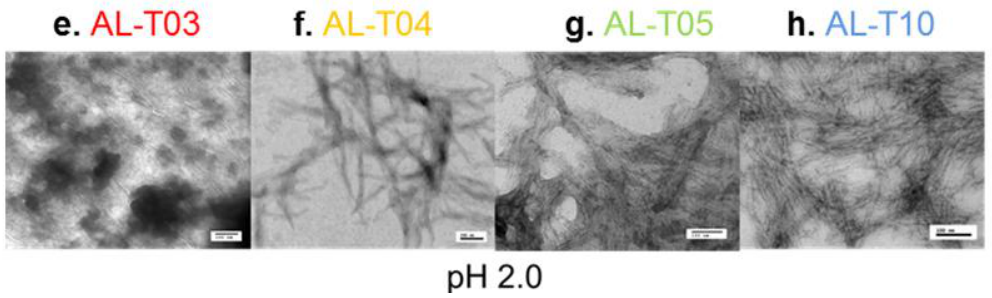
Figure 6. The relationship between T m and t50 ( a ) at pH 7.4 and ( b ) pH 2.0. Linear fitting was performed at pH 7.4 with the equation